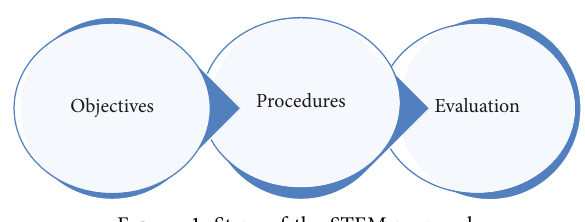
Figure 1: Steps of the STEM